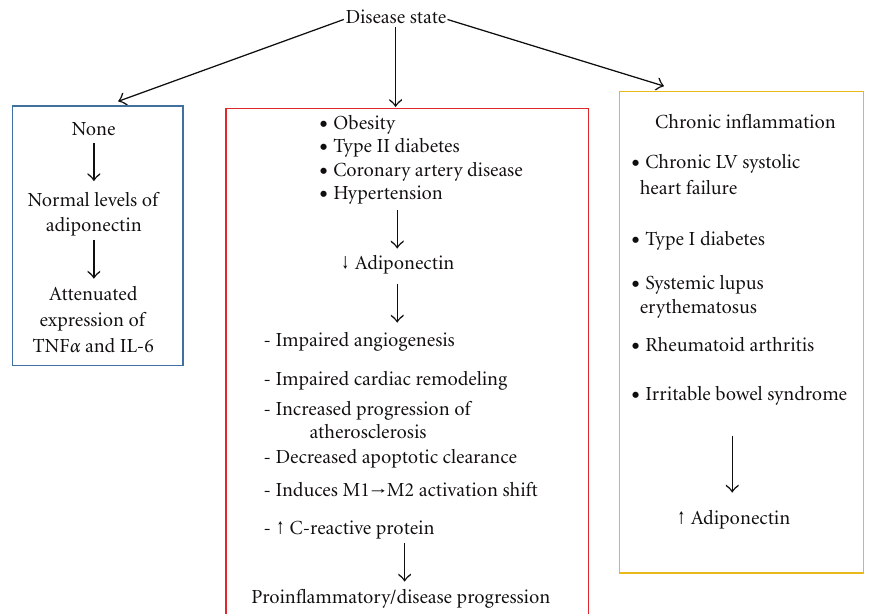
Figure 1: Adiponectin levels and inflammatory state. In healthy individuals, adiponectin maintains anti-inflammatory properties. Disease states where adiponectin levels decrease result in proinflammatory signaling and exacerbation of disease. Recent data has shown that adiponectin levels are increased in chronic inflammatory diseases, but the reason for this is incompletely